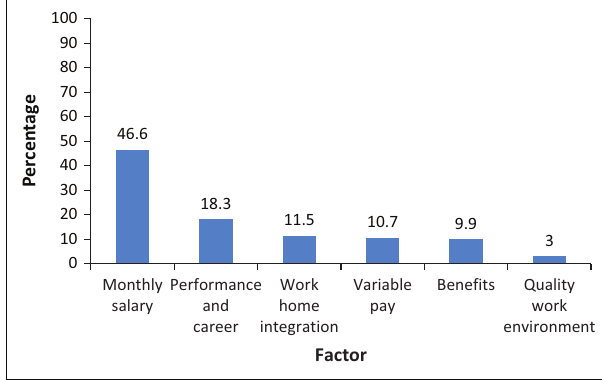
FIGURE 3: Ranking of factors which promote employee